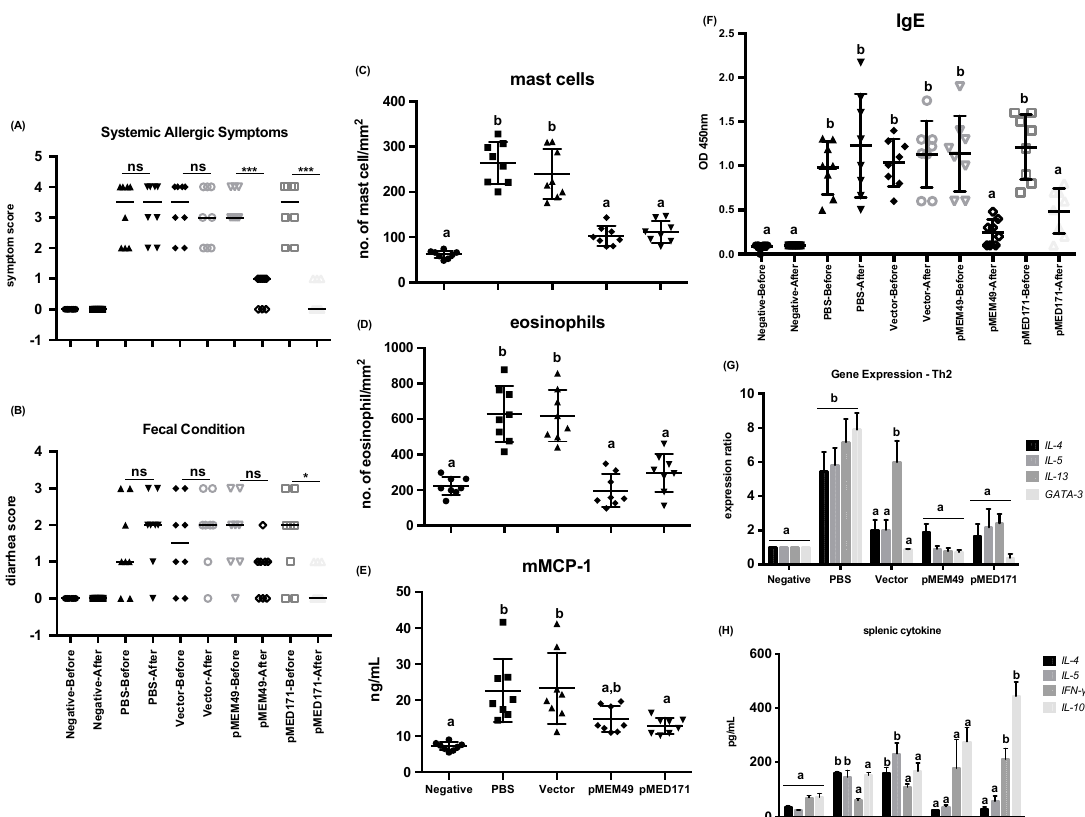
Figure 1. Therapeutic efficacies of pMEM49 and pMED171. ( A ) Scores of systemic allergic responses and ( B ) fecal condition recorded within 40 min post-challenge. Data are presented as individual data points denoted by different symbols for each experimental group with median and between group differences were assessed by Mann–Whitney U test. * p < 0.05; *** p < 0.001 and ns = not significant. Quantification of ( C ) mast cells per mm 2 of crypt area and ( D ) eosinophils per mm 2 of villus in the small intestine. Levels of serological ( E ) mouse mast cell protease-1 and ( F ) tropomyosin-specific IgE measured by ELISA. ( G ) Expression of Th2 cytokines and transcription factors in the small intestine detected by qPCR and ( H ) levels of cytokines produced by spleen cells restimulated by rMet e 1, measured by sandwich ELISA. Note the significant reductions in Th2 systemic and local responses upon pMEM49 and pMED171 treatment. Data are shown as individual data points denoted by different symbols for each experimental group with mean ± SD. Statistical differences among experimental groups were determined by Bonferroni post-test after one-way ANOVA; groups denoted by the same alphabet are not significantly different, while those denoted by different alphabets are statistically different ( p < 0.05).